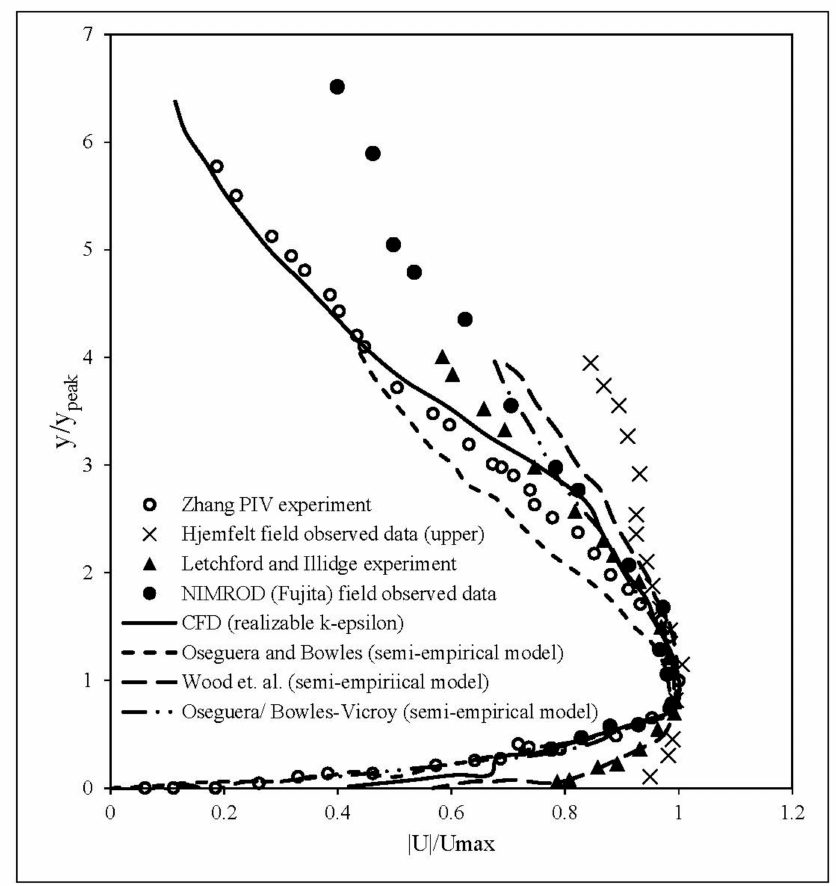
Figure 4. CFD results (RANS) validated with published particle image velocimetry (PIV) experimental data of Zhang. [21] The present result using the realizable k- ε turbulence model at Re = 288,046, H/D = 2 at r/D = 1.0 is shown as the solid line. U max is the maximum speed of the outflow near the ground, and y peak is the corresponding height where the maximum speed